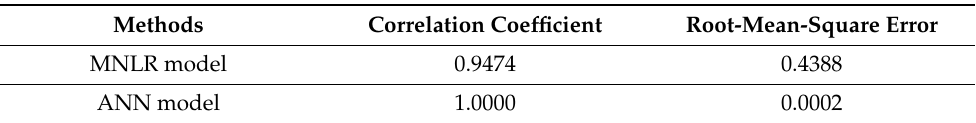
Figure 10. The correlation between the predicted and observed LOI values of ( a ) the MNLR model and ( b ) the ANN model. Adapted with permission from ref. [101]. Copyright 2001 Journal of Fire Sciences. Table 5. A comparison of prediction capability between multiple nonlinear regression (MNLR) analysis and the ANN model